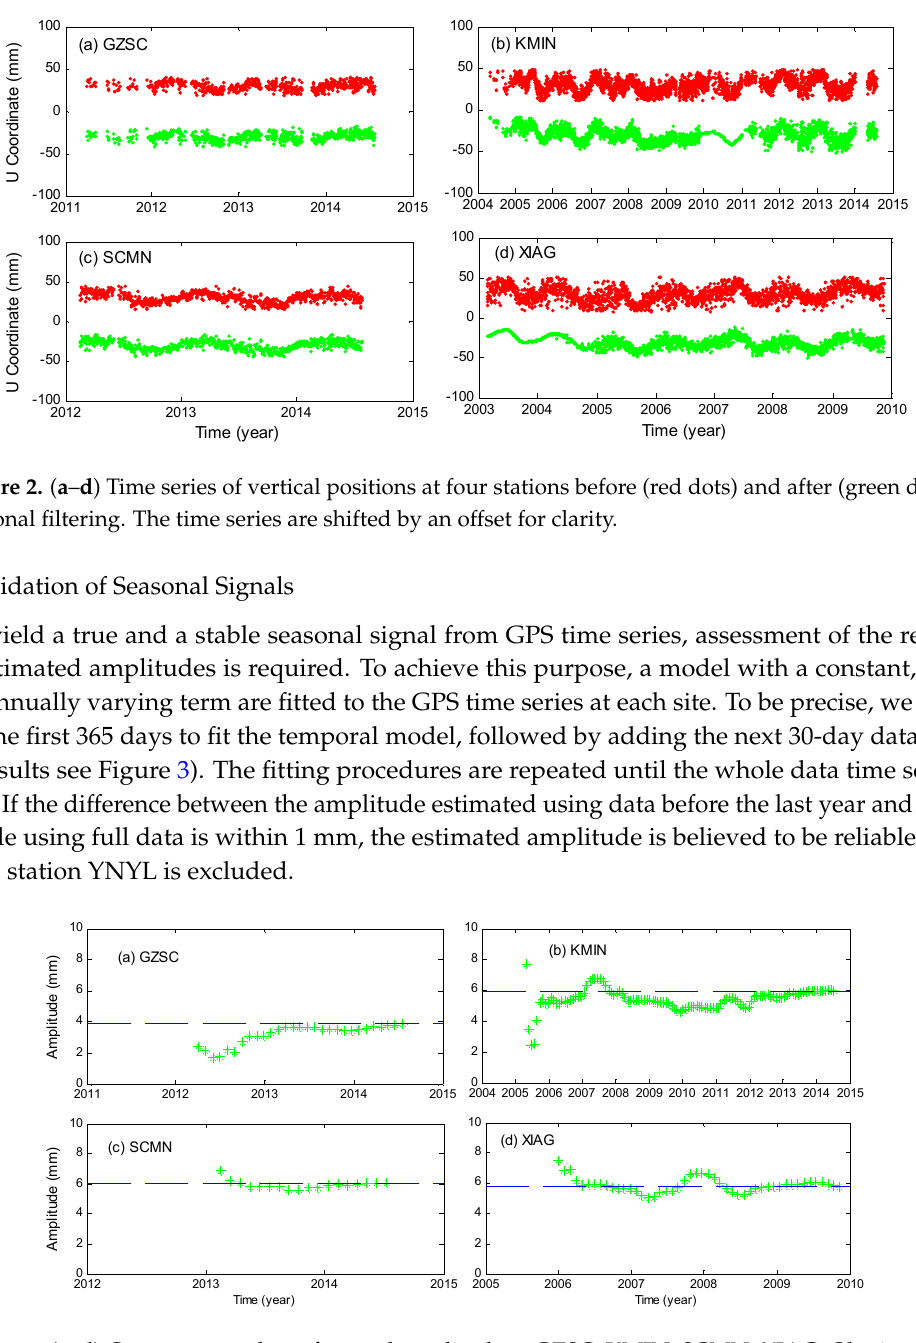
Figure 3. ( a – d ) Convergence plots of annual amplitude at GZSC, KMIN, SCMN, XIAG. Obtained by fitting constant, linear and annual terms to the first 365 days of the data, followed by adding that of the next 30 days and the fit is repeated until all data are used.